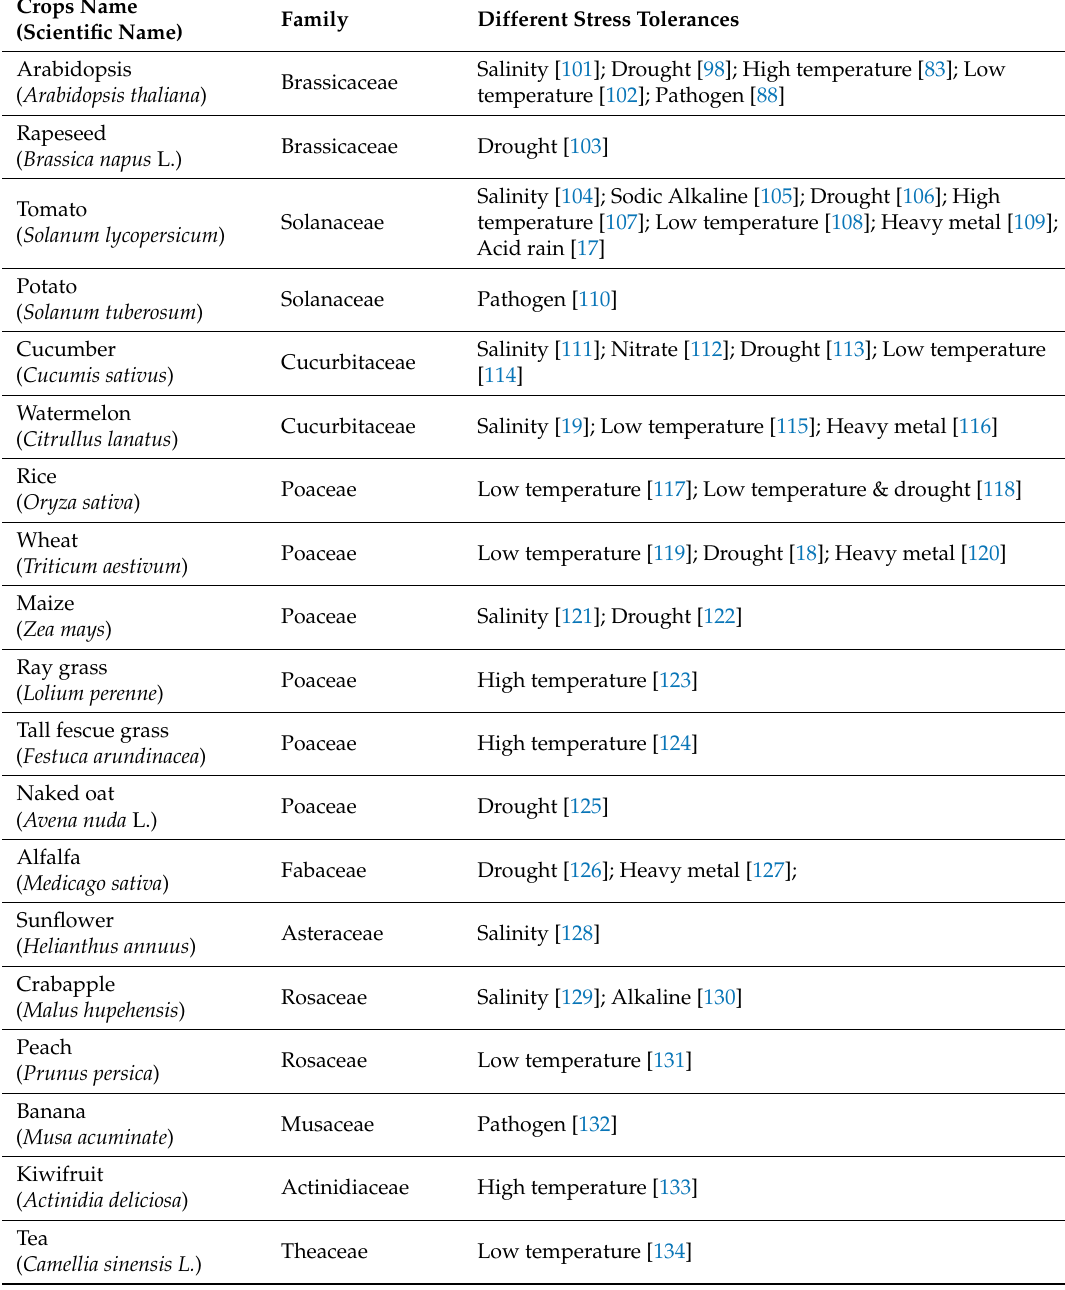
Table 2. Exogenous melatonin improves abiotic and biotic stress tolerance in different